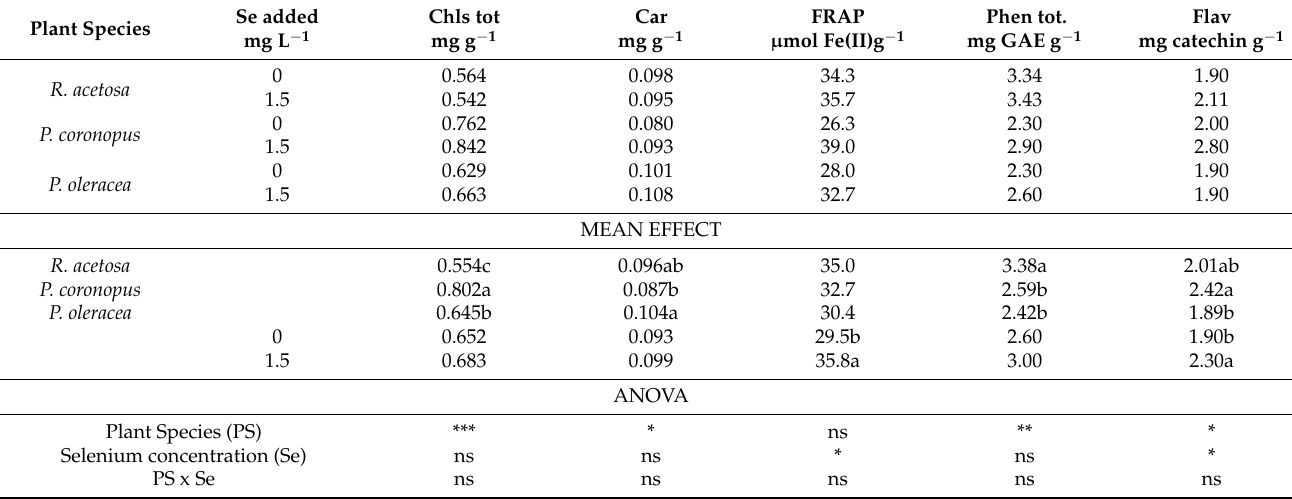
Table 3. Total chlorophyll (Chls tot) and carotenoid (Car) content, antioxidant capacity (FRAP), total phenols (Phen tot.), and flavonoid (Flav) content, expressed as fresh weight in microgreens of various wild plant species grown indoors under controlled conditions with different concentrations of Se in the